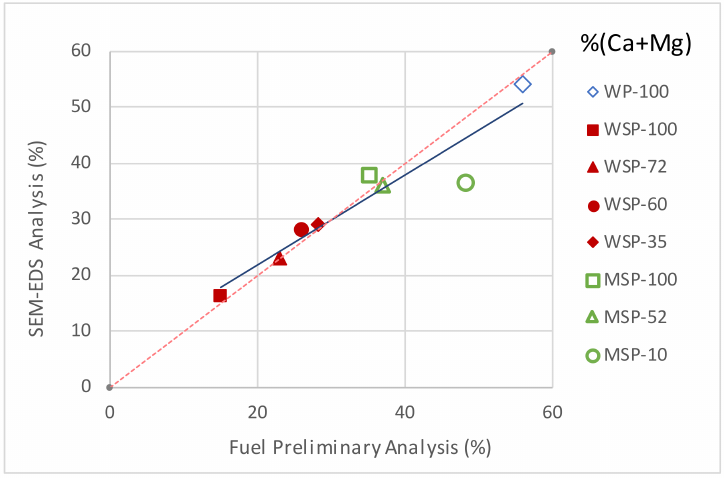
Figure 2. Ca + Mg concentration in bottom ash versus Ca + Mg concentration in fuel preliminary